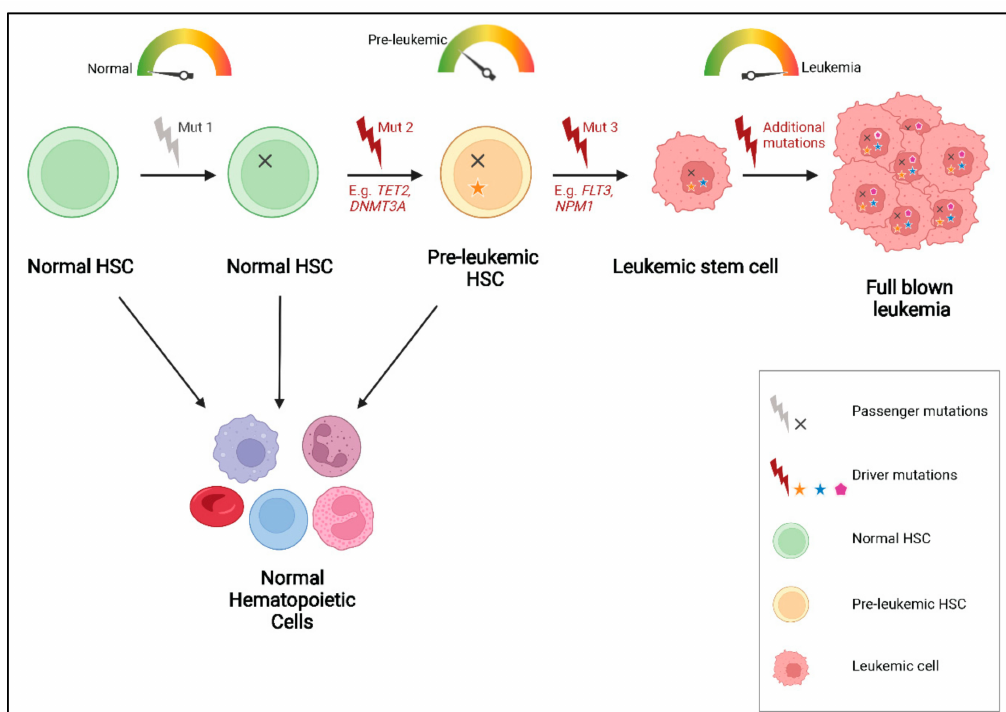
Figure 3. Pre-leukemic HSCs and CHIP/ARCH: Some healthy individuals, particularly older people, harbor mutations in genes such as TET2 , DNMT3A or IDH1/2 (mutation 2), resulting in a population of pre-leukemic HSCs, which retain the ability to proliferate and differentiate into normal blood cells. However, on acquiring additional leukemia driver mutations (mutation 3), these cells might undergo malignant transformation which can eventually lead to leukemia